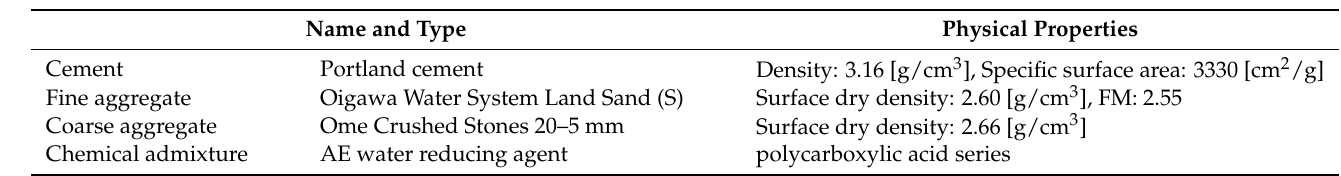
Table 10. Materials.